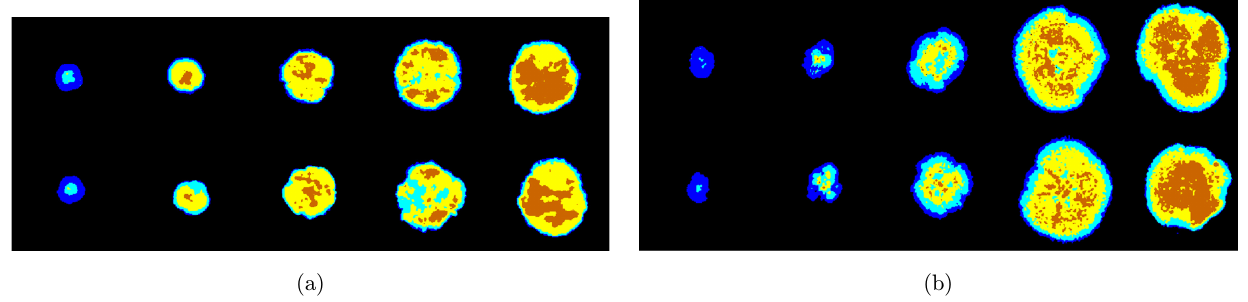
Fig. 7. Prediction image of growth zones on colonies. (a) Prediction image of growth zones on colonies incubated on RBM. (b) Prediction image of growth zones on colonies incubated on MAM. (Classi¯cation based on the training data is in the upper row, and the bottom row is the classi¯cation result of the independent validation